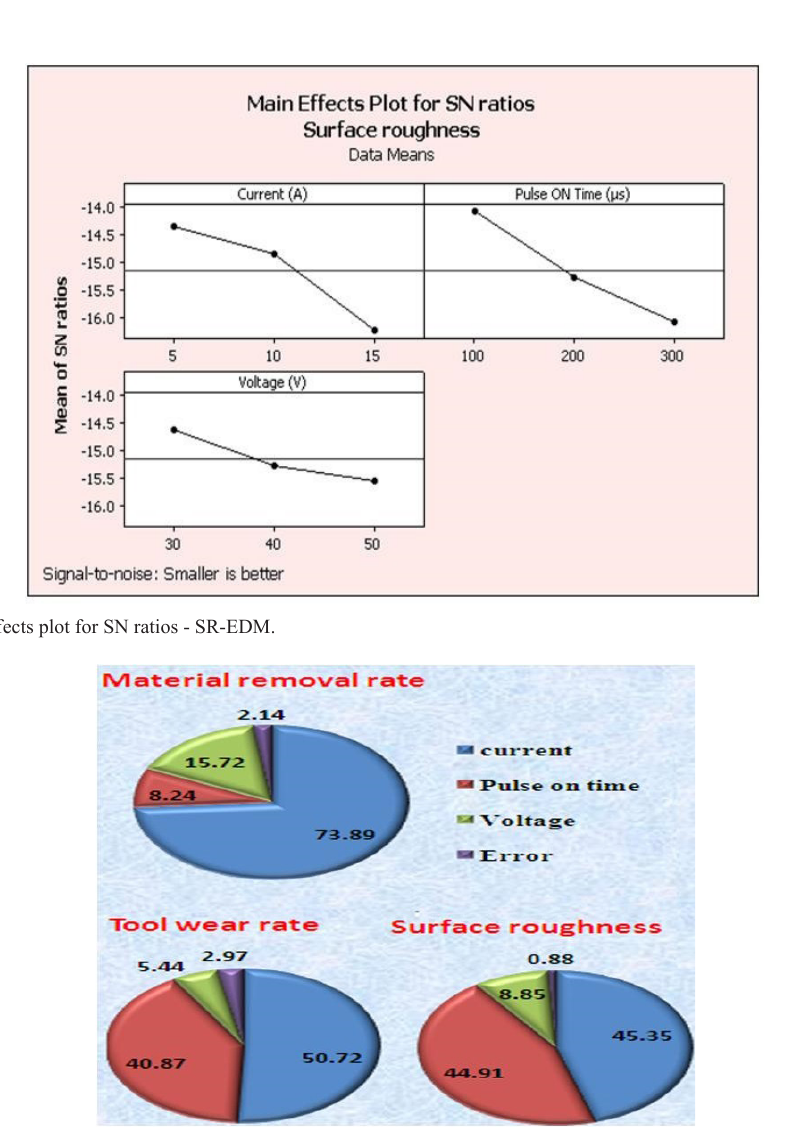
Figure 6. Percentage of contribution for each input parameter on the responses Table 3. Analysis of variance for EDM.